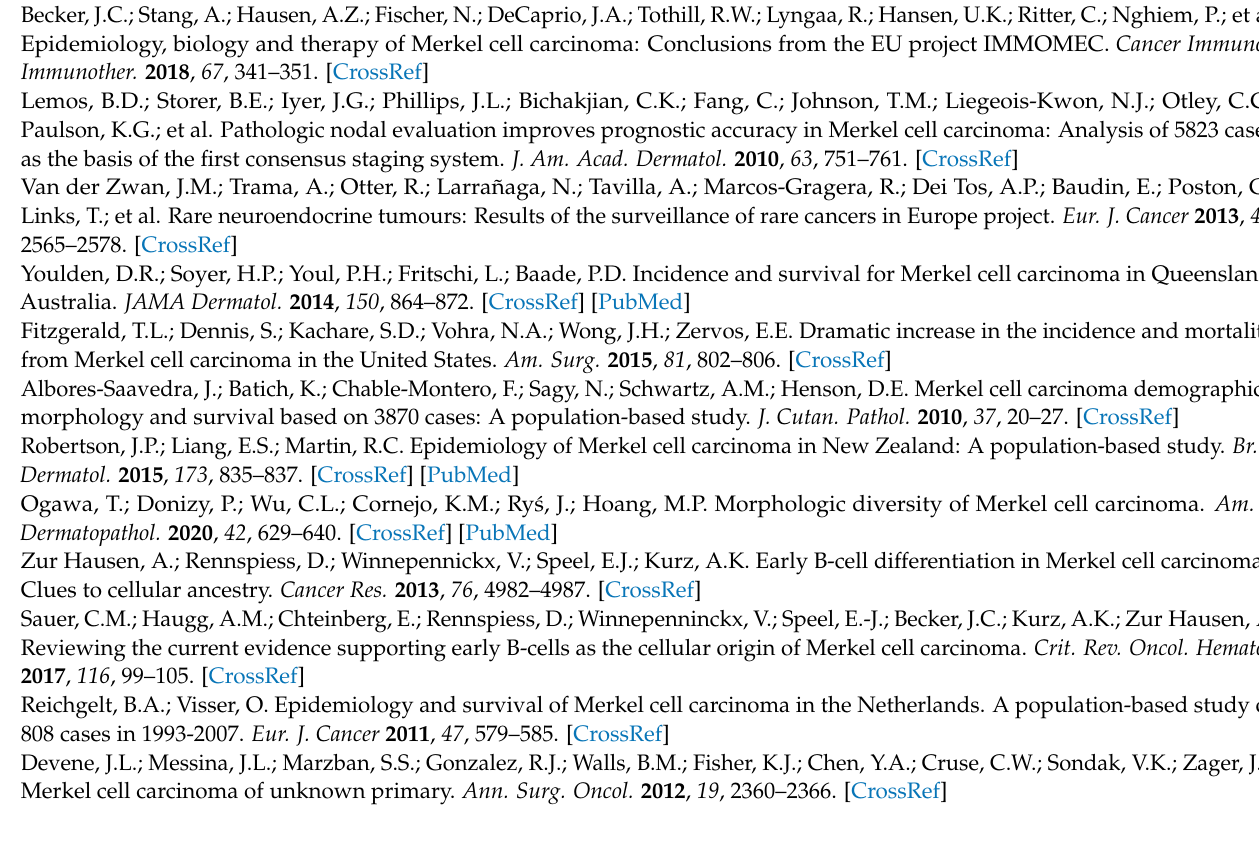
Table S6: The gene targets covered by next generation sequencing